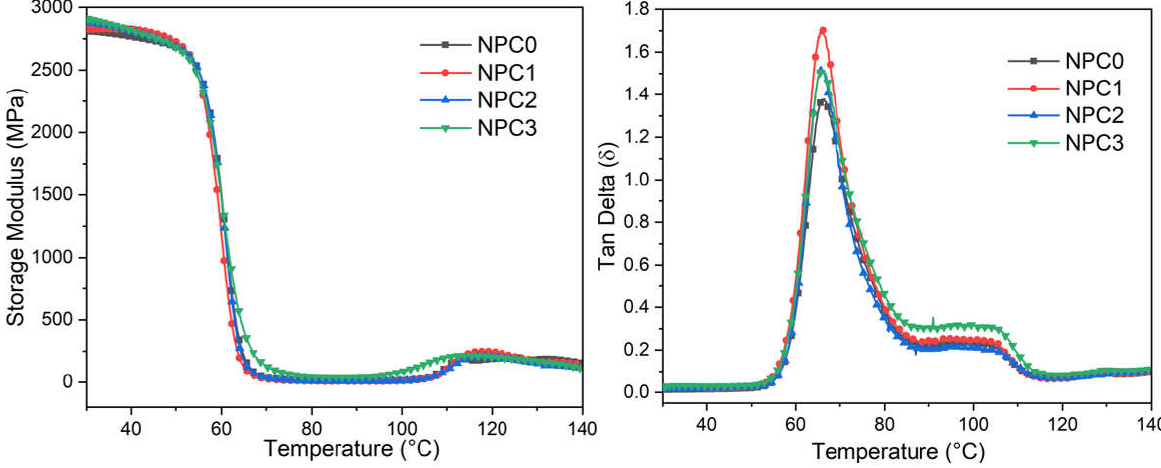
Figure 6. Results from DMA test for PLA-based NPCs.